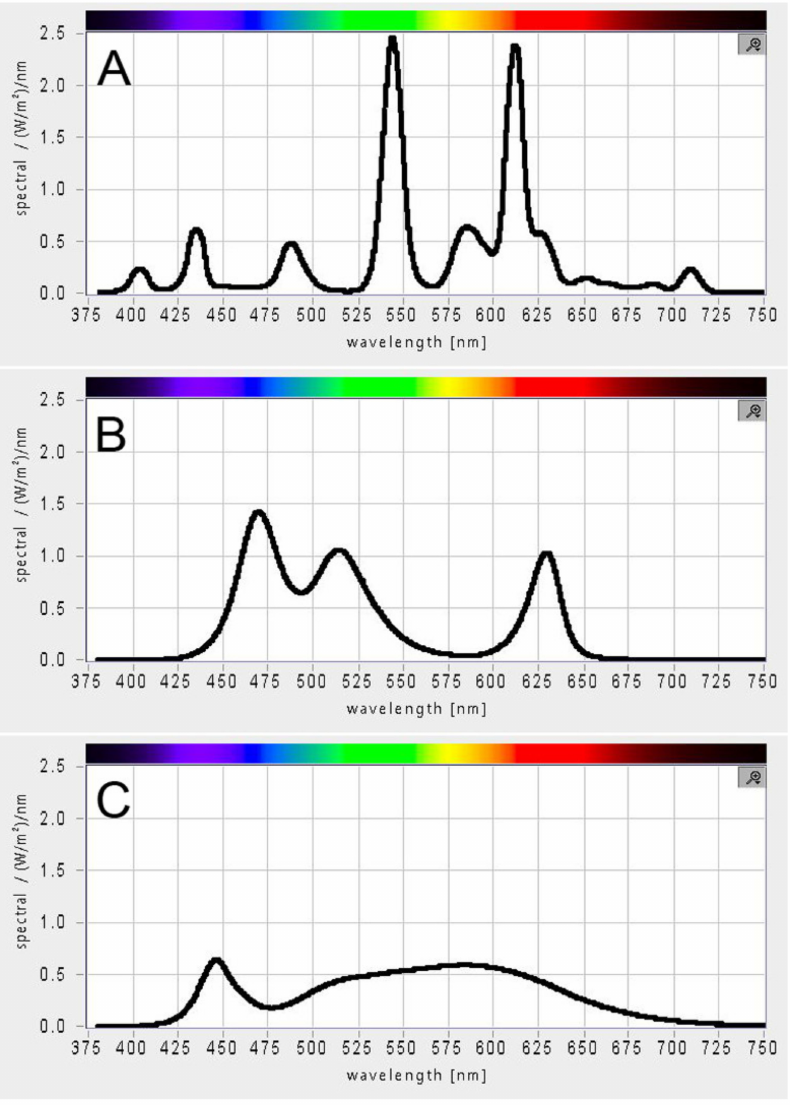
Figure 2. PAR spectrum of white light sources used for microalgae cultivation. ( A ) Fluorescent lamps, ( B ) RGB LEDs, ( C ) white